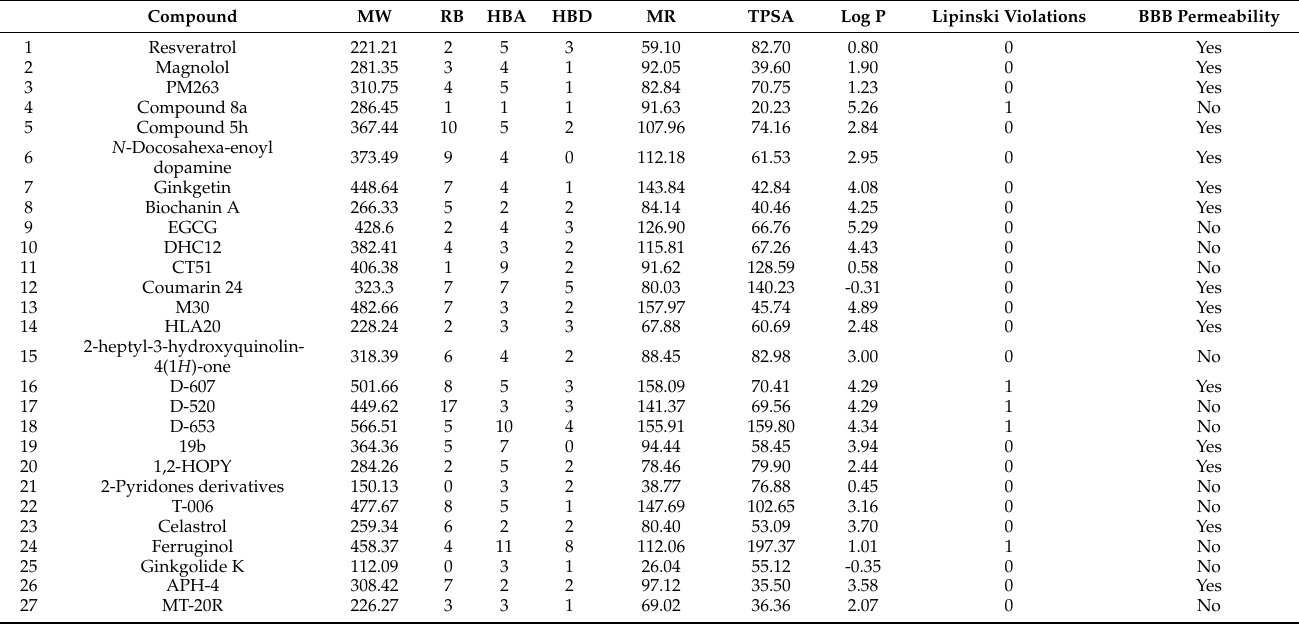
Table 2. In silico prediction of drug-likeness *.